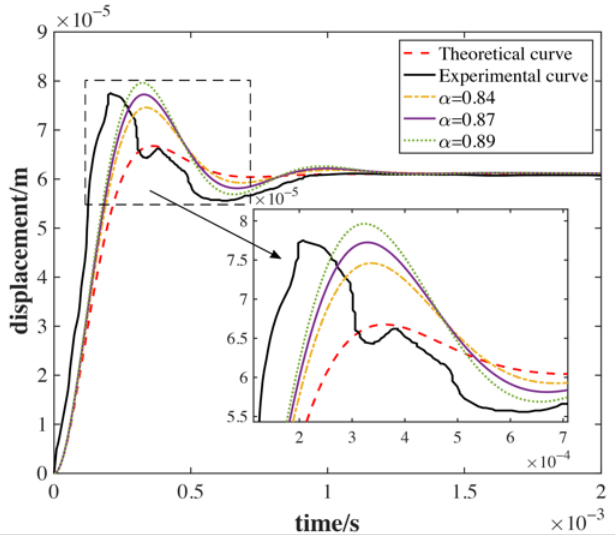
Figure 5. Experimental step response curves of GMA and step response curves of different fractional orders.